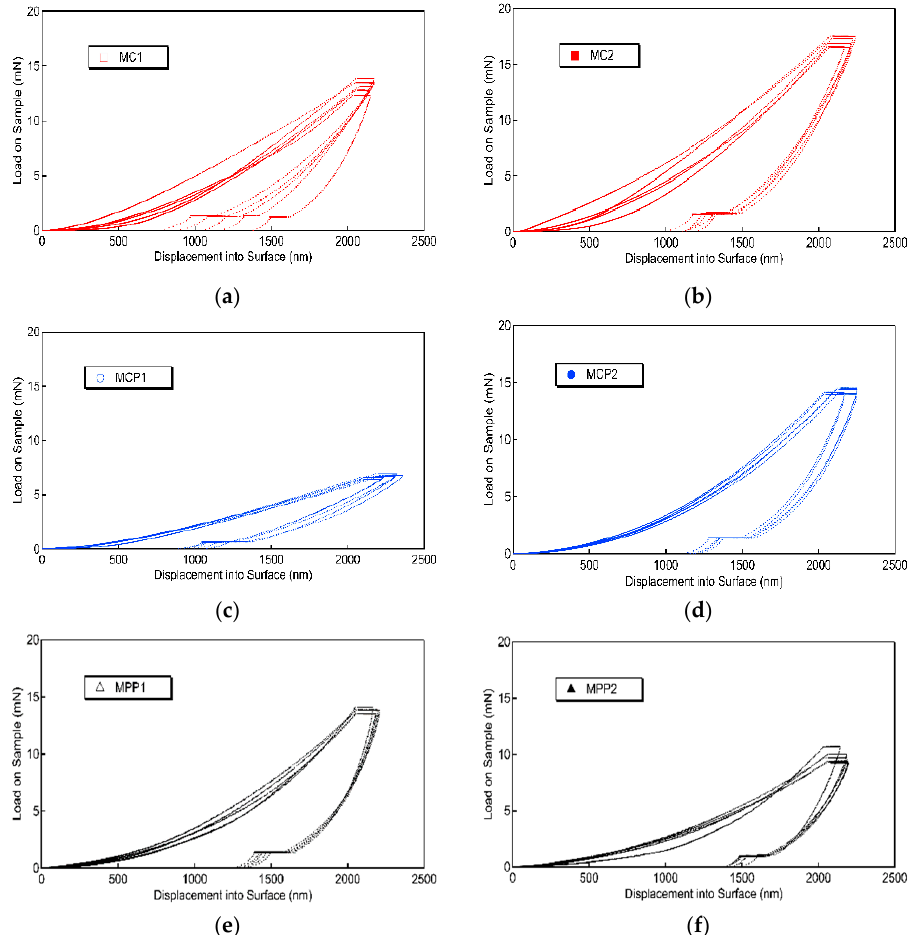
Figure 4. Nanoindentation measurements: load–displacement curves recorded for each membrane before ( a,c,e ) and after ( b,d,f ) PRGF treatment. The images correspond to Jason ® ( a,b ), Biocollagen ® ( c,d ), and Cova TM Max ( e,f ). Legend: MC1/MC2 = Jason ® membrane before/after PRGF treatment; MCP1/MCP2 = Biocollagen ® membrane before/after PRGF treatment; MPP1/MPP2 = Cova TM Max membrane before/after PRGF treatment.